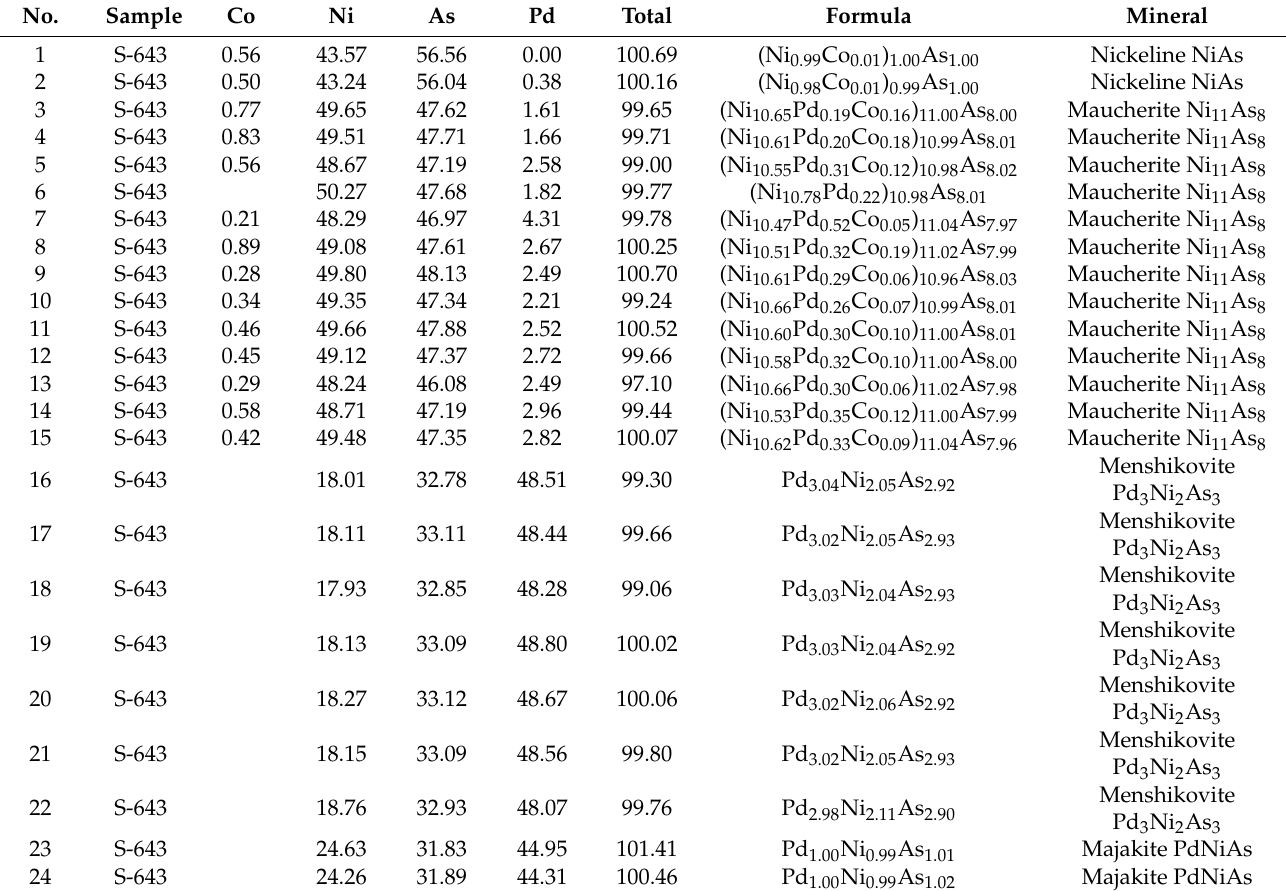
Table 3. Composition of Ni and Pd arsenides of the Skalisty mine (wt.%).